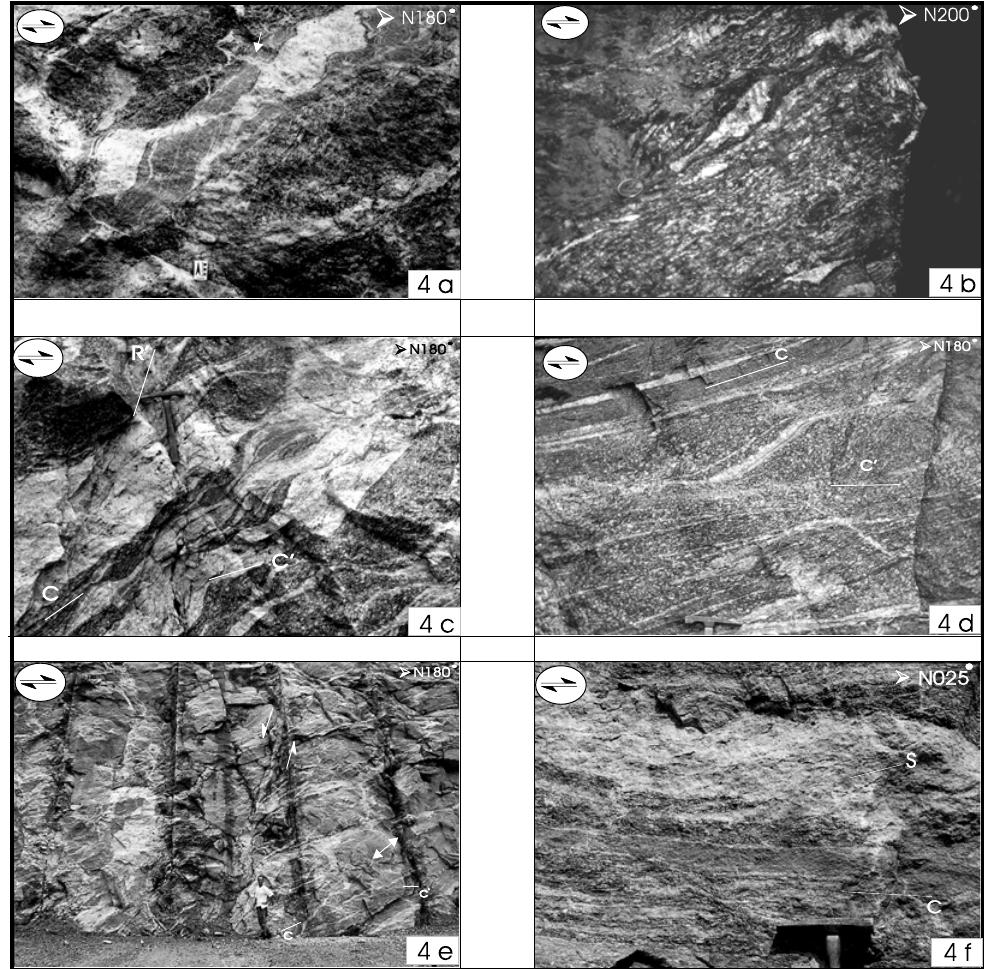
Fig. 4 – Kinematic indicators in the southern limb of the structural divergent fan (always in sections subparallel to the XZ plane of the finite strain elipsoid): (a) asymmetrical boudins and pinch-and-swell structures. Note the granite apophysis cutting the host granite – white arrow; (b) asymmetrical centimetric porphyroclast in high-grade, coarse-grained mylonites of the SAS; (c) asymmetrical pull- apart structure. Note the development of synthectic (C’) and antithectic (R’) shear band foliation and the association with leucogranite; (d) C’ extensional shear-bands developed in orthogneisse mylonite of the RSSZ. All described structures suggest top-to-SSW sense of shear; (e) Decametric ductile extensional (top-down to NNE) shear band deforming the earlier SSW-directed fabric of the RSSZ (see also fig. 4c); (f) SC fabric deforming granite sheets in mylonitic orthogneiss. The asymmetry suggests top-down-to NE sense of shear.